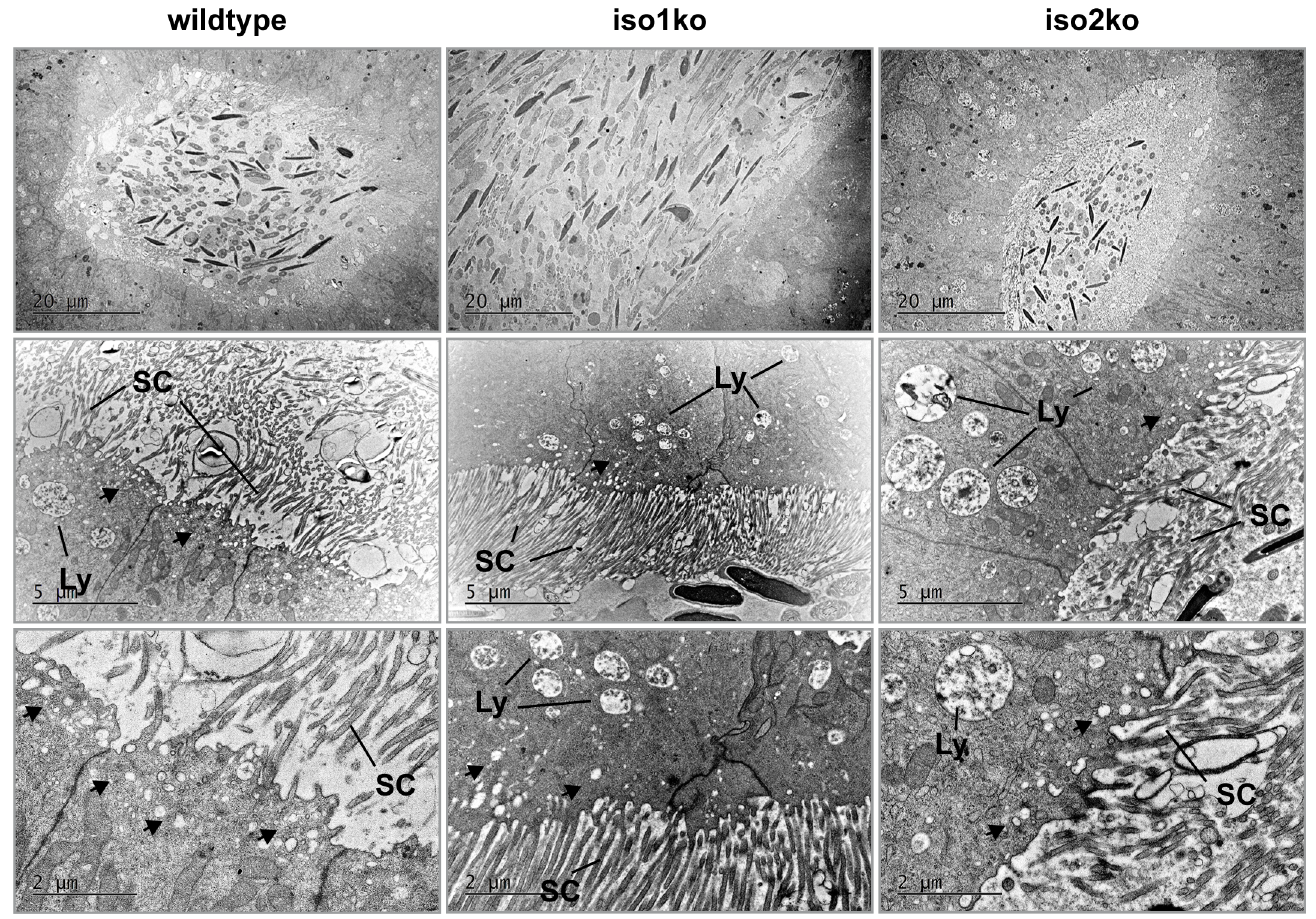
Fig 9. Increased lysosome formation in epididymis of ko animals. Electron micrographs of the caput epididymis revealed increased lysosome (Ly) formation but a lower abundance of small secretory vesicles (arrows). Stereocilia (SC) appeared normal in morphology and